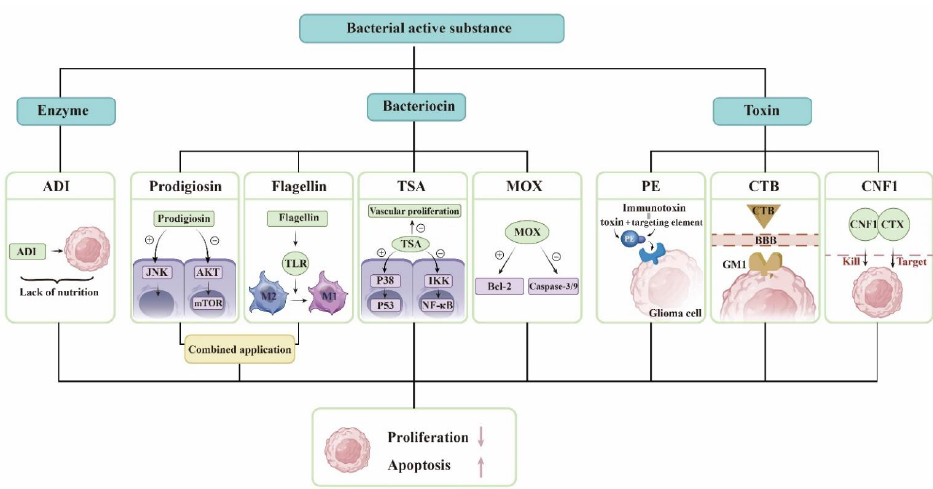
Figure 1. Derivatives of microorganisms are used to treat gliomas. The bacterial active substance includes enzymes, bacteriocins, and bacterial toxins. The list some of substances and their mechanisms of action. ADI exhausts arginine in the tumor and makes the tumor lack of nutrition. Prodigiosin activates the JNK pathway and reduce the AKT/mTOR pathway in GBM cells. Flagellin modulates the conversion of TAM from M2 to M1 type. TSA leads to p53 phosphorylation by activating p38MAPK and inhibits NF- κB activity by inducing IKK dephosphorylation. TSA also inhibits GBM vascular proliferation. MOX increases the ratio of Bcl-2-associated X protein/B-cell lymphoma 2 and activates the caspase-3/-9 cascade. PE and proteins that target gliomas constitute immunotoxins. CTB can pass the BBB and is targeted. CTX and CNF1 are responsible for identifying and killing glioma cells, respectively. They all promote glioma cell apoptosis and inhibit glioma proliferation.